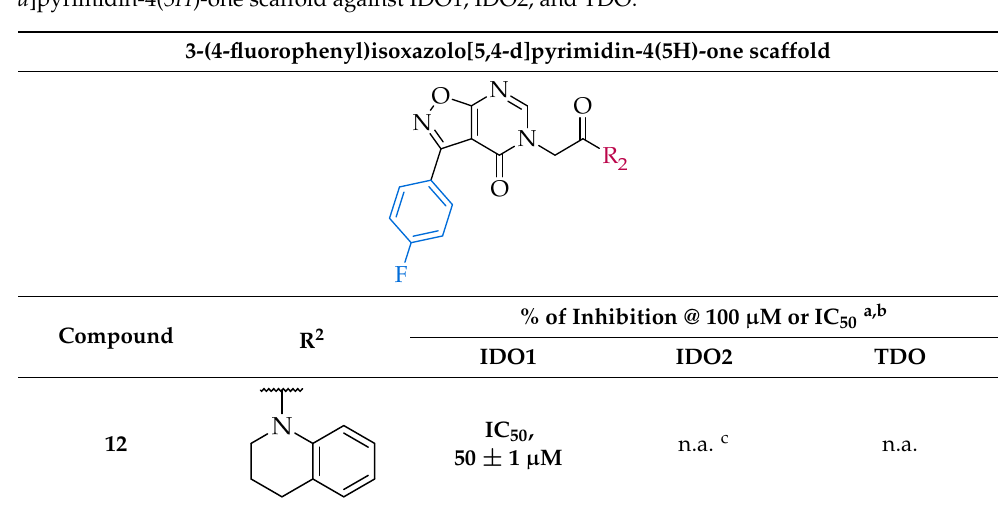
Scheme 1. Synthetic procedure for the preparation of isoxazolo[5,4- d ]pyrimidin-4(5 H )-one derivatives. Reagents, condi-